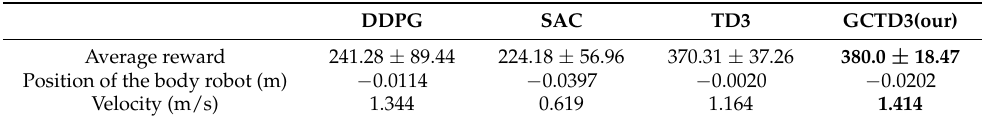
Table 5. Average rewards, mean body position, and average robot velocity obtained when evaluating algorithms in 50